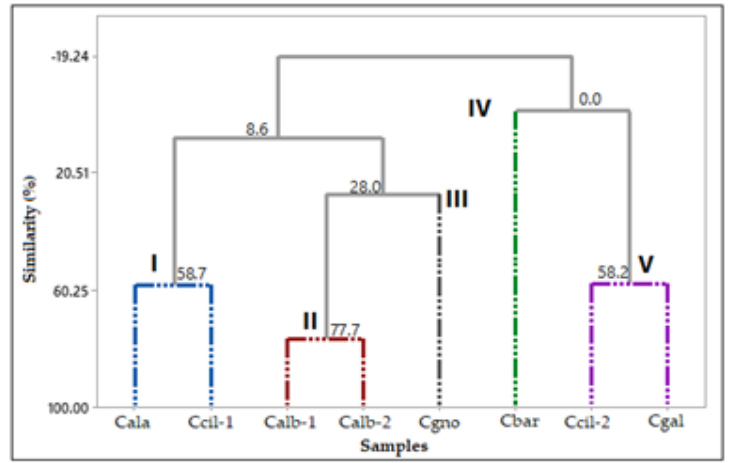
Figure 13. Hierarchical cluster analysis (HCA) of the Catasetum volatile concentrates, based on their classes of compounds.